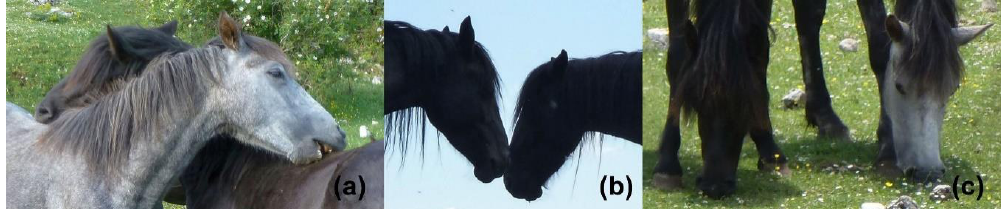
Figure 1. Pairwise involvement in ( a ) mutual grooming, ( b ) friendly approach, and ( c ) spatial proximity.